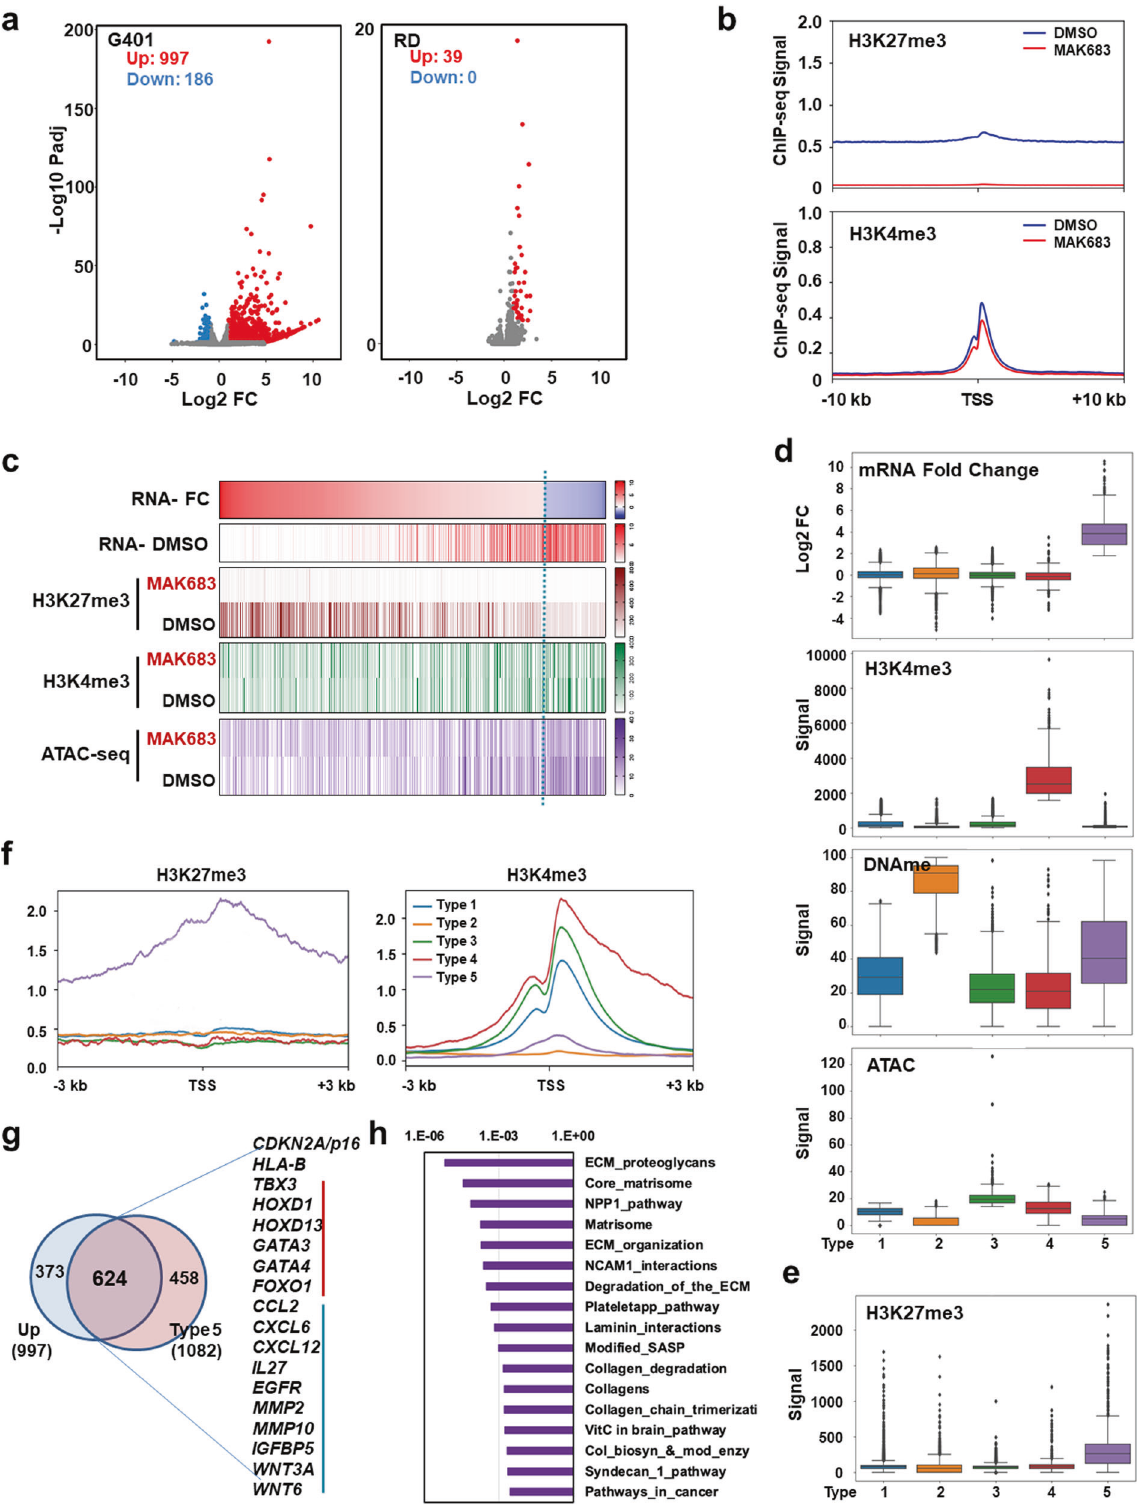
induced signi fi cant upregulation of p16, ECM and SASP factors, and promoted macrophage in fi